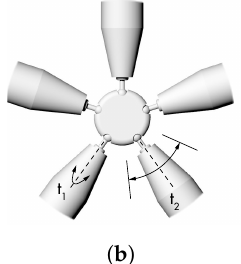
Figure 3. The tolerance embedded in different joint designs. ( a ) Joint design with minimal toler- ance [45,46]. The tolerance is measured rotationally around the members’ axis. ( b ) Joint design with a high level of tolerance [36]. The level of tolerance differs, depending on the plane the members move in. Reprinted with permission from [6].